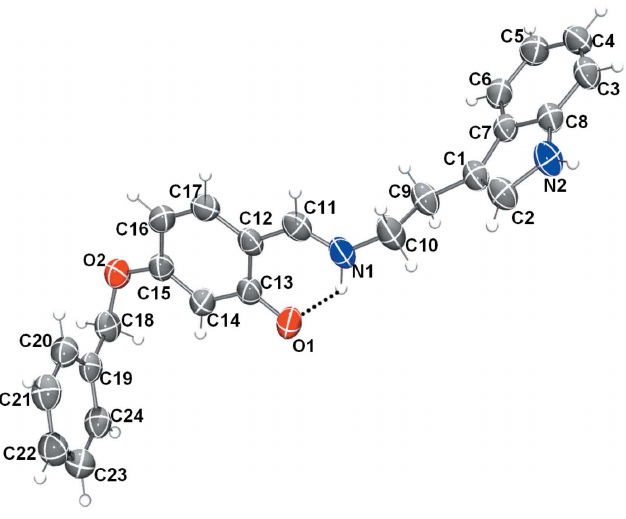
Figure 2 View of the molecular structure of compound (II), with the atom labelling. Displacement ellipsoids are drawn at the 50% probability level. The intramolecular charge-assisted N + —H (cid:2)(cid:2)(cid:2) O (cid:4) hydrogen bond (see Table 2) is shown as a dashed line.